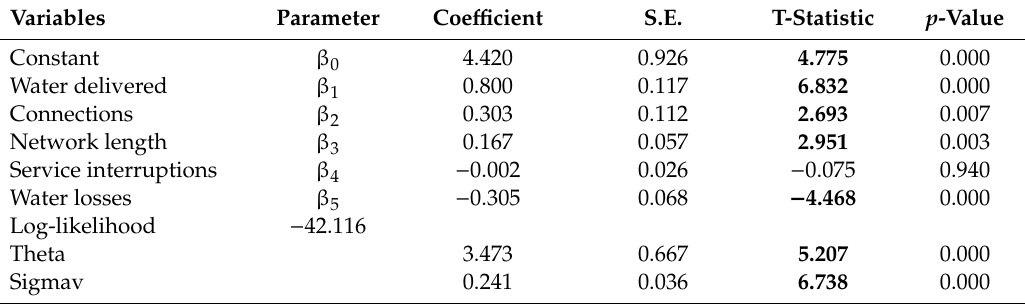
Table A2. Estimates of the cost frontier model for the best scenario.